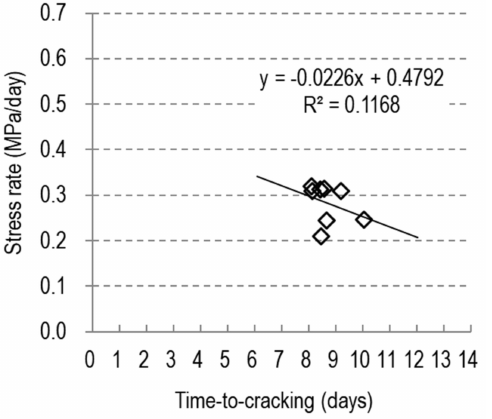
Figure 14. Relationship between net time to cracking and stress rate.